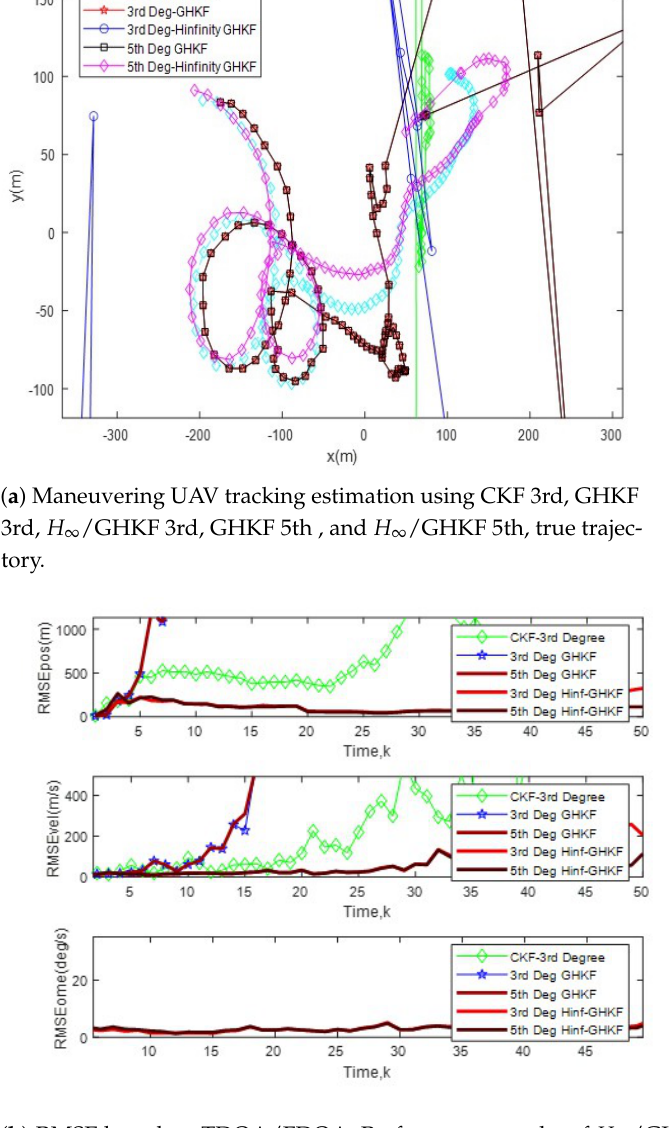
Figure 33. Comparing the performance of target tracking algorithms